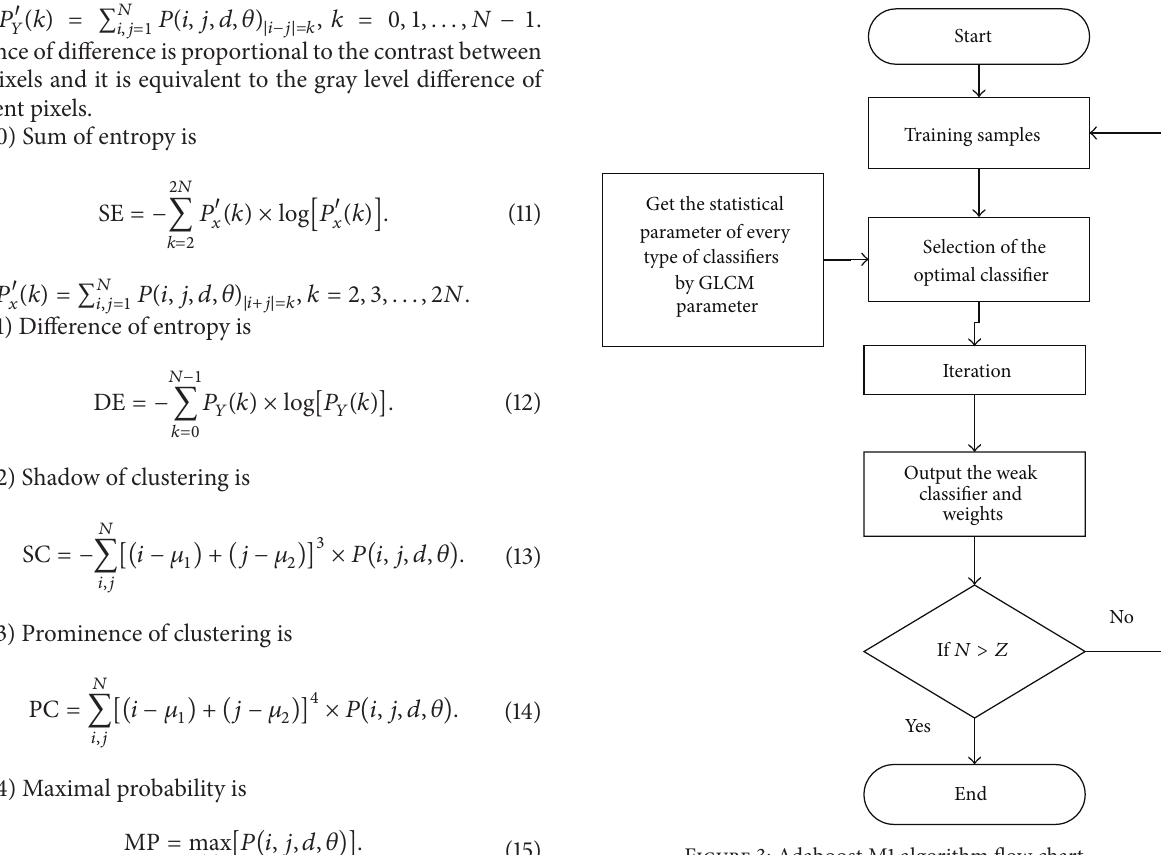
Figure 3: Adaboost M1 algorithm flow